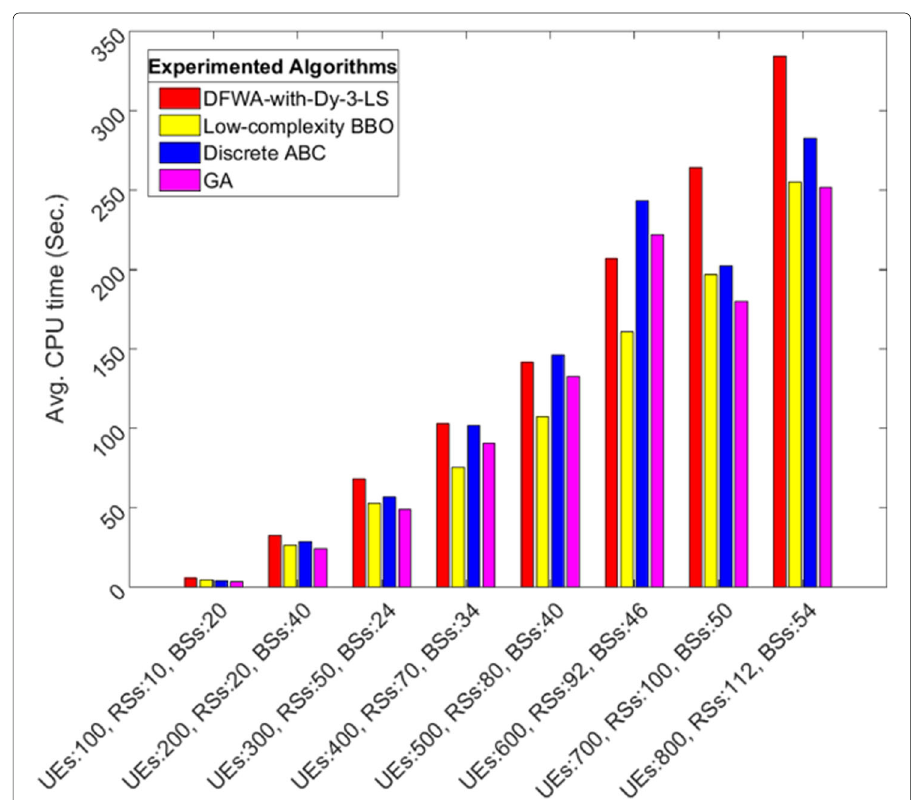
Fig. 5 Average CPU time (Sec.) for the experimented algorithms